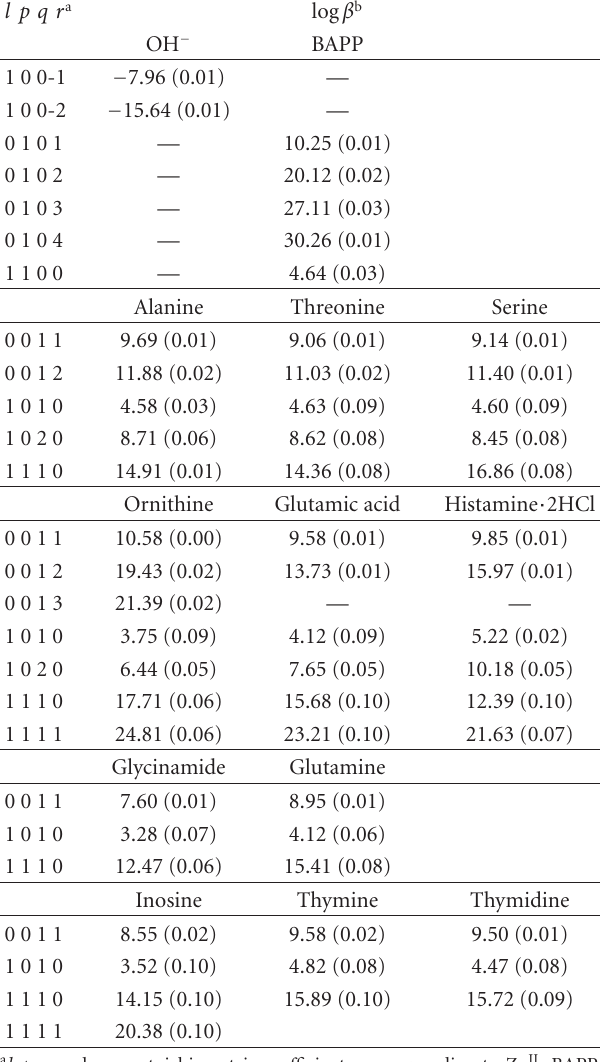
Table 6: Stability constants of the ternary species in the Zn II - BAPP-amino acid, amide, or DNA constituent systems and proton- association constants and their binary stability